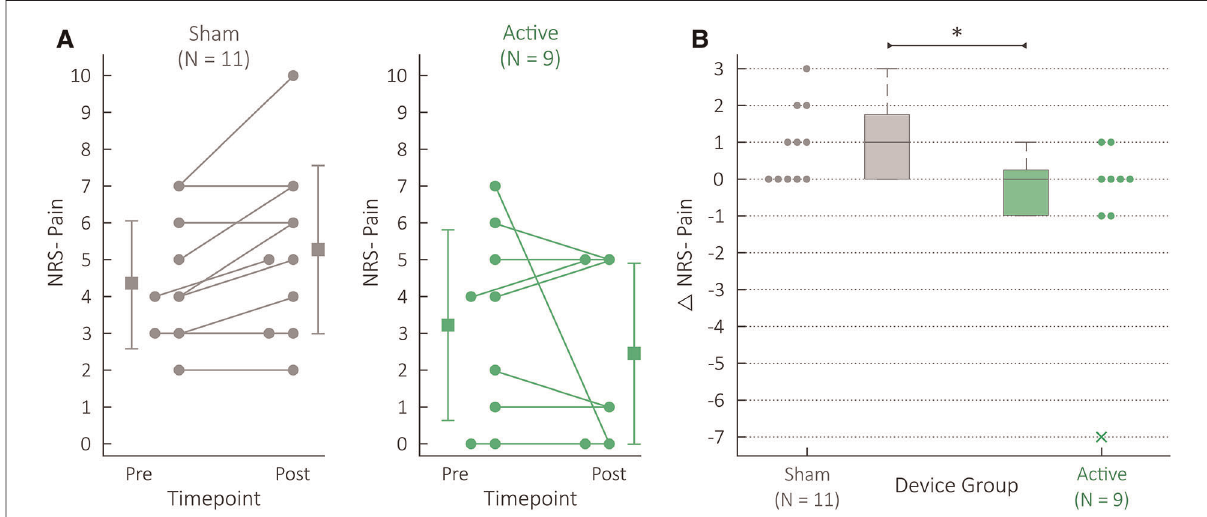
FIGURE 3 NRS pain scores for the active (green) and sham (gray) groups. ( A ) Each patient ’ s NRS Pain datapoints. “ Pre ” datapoints refer to the NRS Pain scores collected at the beginning of the protocol; “ Post ” datapoints refer to the NRS Pain scores collected at the end of the protocol. Each patient ’ s pair of scores is connected using a line; if two patients reported the same pain levels for both pre and post, one patient ’ s pre and post datapoints were shifted to the left for the ease of visualization. The summary statistics depict the mean and standard deviations for the pre and post data. ( B ) Comparison of active and sham Δ NRS Pain scores. The Δ denotes differences between the post and pre NRS Pain data. Note that this Δ NRS Pain data have been presented with alternative summary statistics in previous work (14). The box and whisker plots summarize the individual Δ NRS Pain datapoints shown, where the active and sham group ’ s data are shown on the right and left, respectively. The x marker is used for outliers, and * indicates P